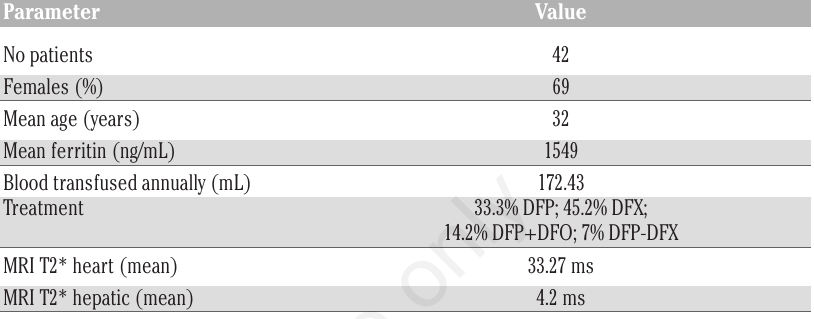
Table 1. Clinical, laboratory and instrumental data of the patients studied.